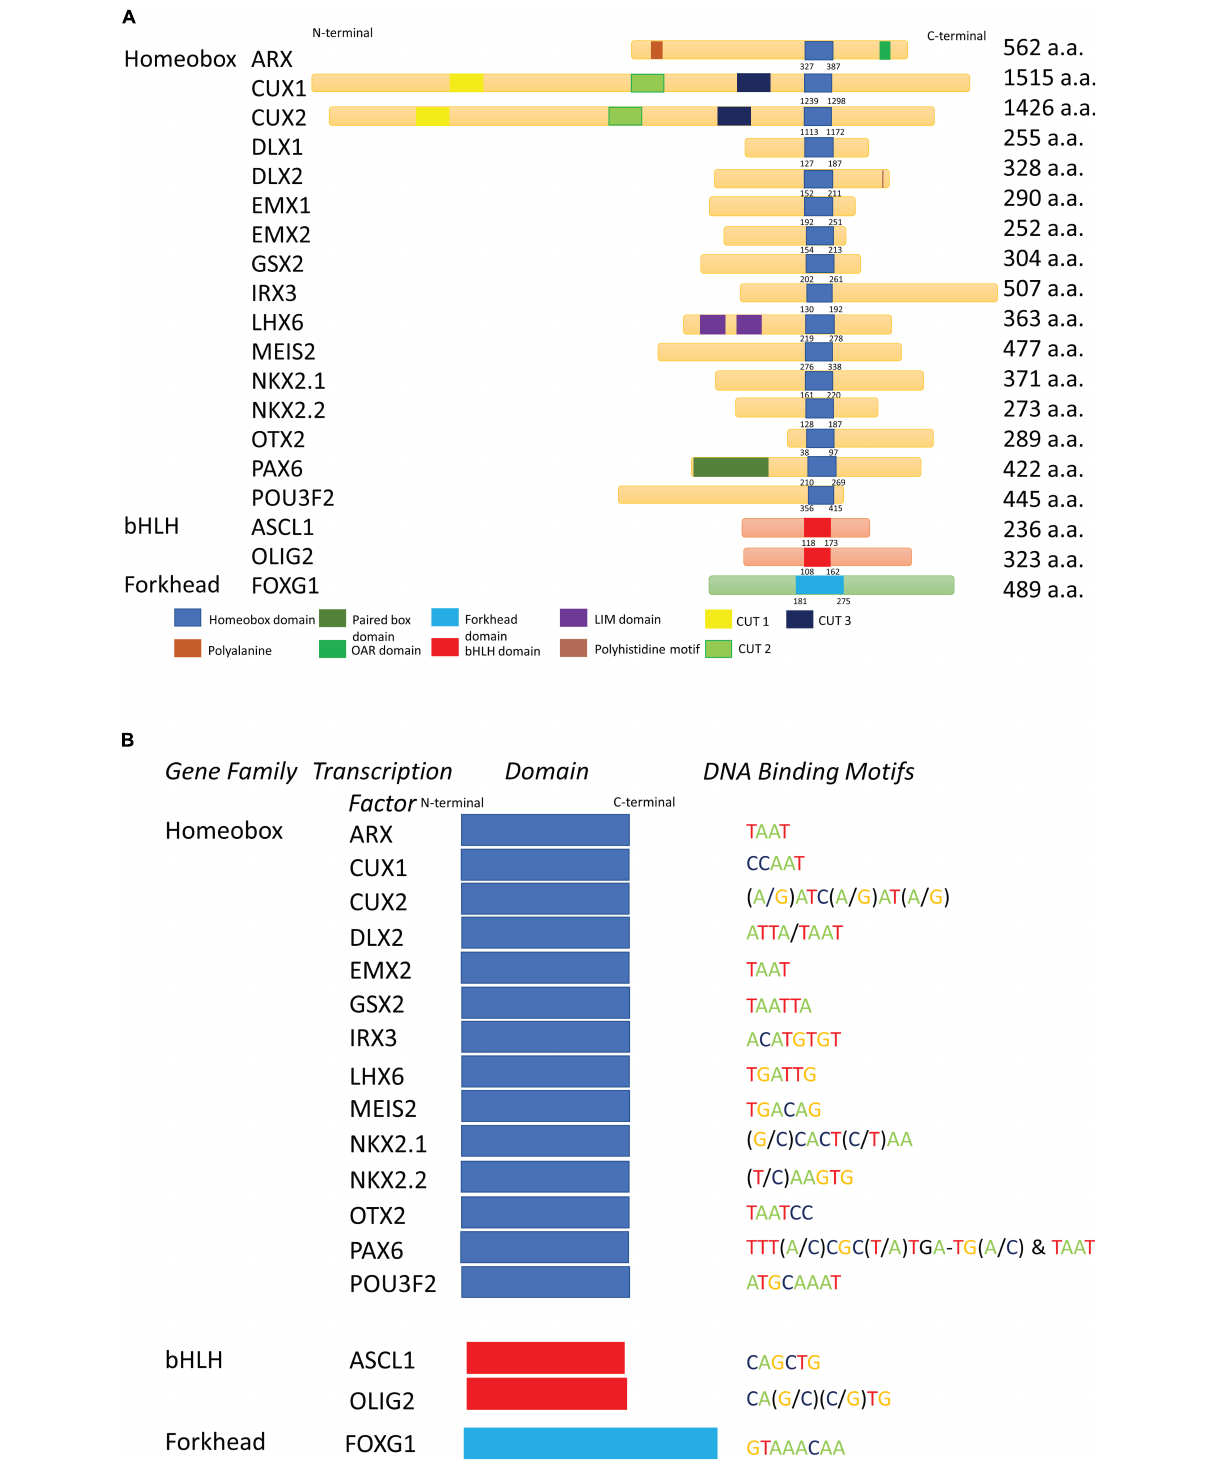
Frontiers in Neuroscience |